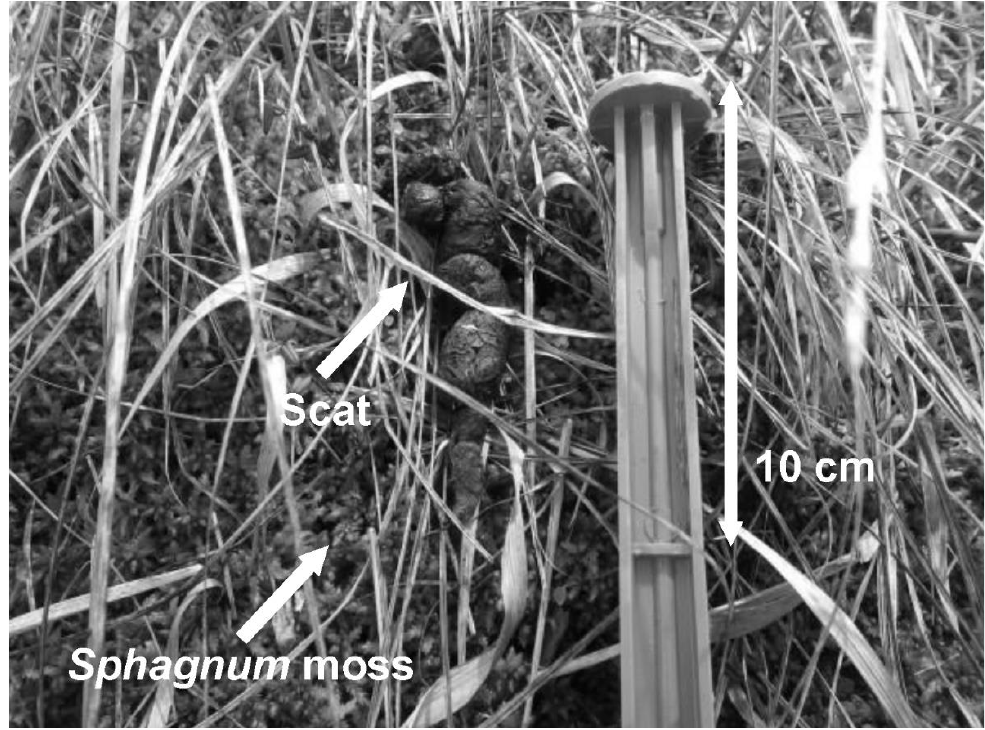
Figure 1. A fresh fox scat spread on a Sphagnum moss mat in post-mined peatland at Sarobetsu Mire, northern Japan, on 22 Apr 2020. The site was mined in